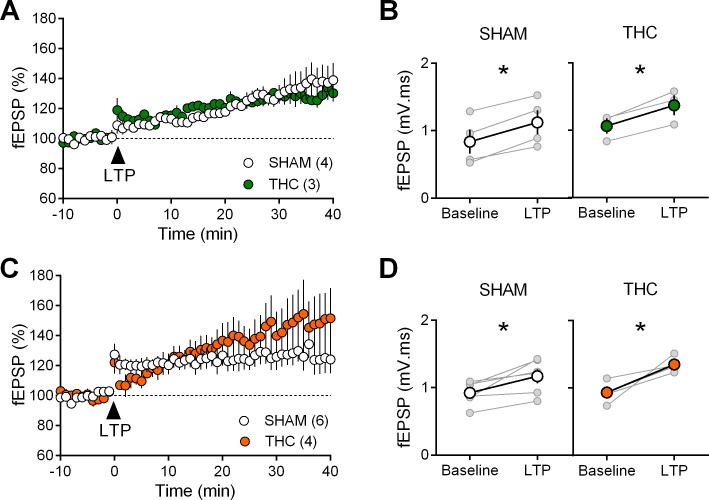
Prenatal THC does not alter long-term potentiation.(A) Average time-courses of mean fEPSPs showing that theta burst stimulation (indicated by arrow) induces LTP at layer V/VI mPFC synapses in both SHAM- (white circles, n = 8) and THC- (green circles, n = 8) exposed male rats. (B) Individual averaged fEPSP amplitude measurements before (baseline) and 40 min after LTP induction. Grey, individual experiments; tan, group averages. In SHAM rats: 0.138 ± 0.011 mV before LTP versus 0.185 ± 0.016 mV after LTP induction (n = 8, p<0.05, paired t-test). In THC male rats: 0.129 ± 0.012 mV before LTP versus 0.177 ± 0.015 mV after LTP induction (n = 13, p<0.05, paired t-test). (C) Identical TBS-LTP induction protocol but recording from female prenatally-exposed animals (SHAM, white circles, n = 8; THC, orange circles, n = 8). (D) Peak amplitude measurements before (baseline) and after (LTP) stimulation protocol from individual experiments (grey) and group averages in SHAM (white, 0.125 ± 0.014 mV before LTP versus 0.150 ± 0.020 mV after LTP; p<0.05, paired t-test) and THC (orange; 0.133 ± 0.010 mV before LTP versus 0.167 ± 0.016 mV after. LTP; p<0.05, paired t-test) animals. *p<0.05. n = individual rats. Error bars represent SEM.